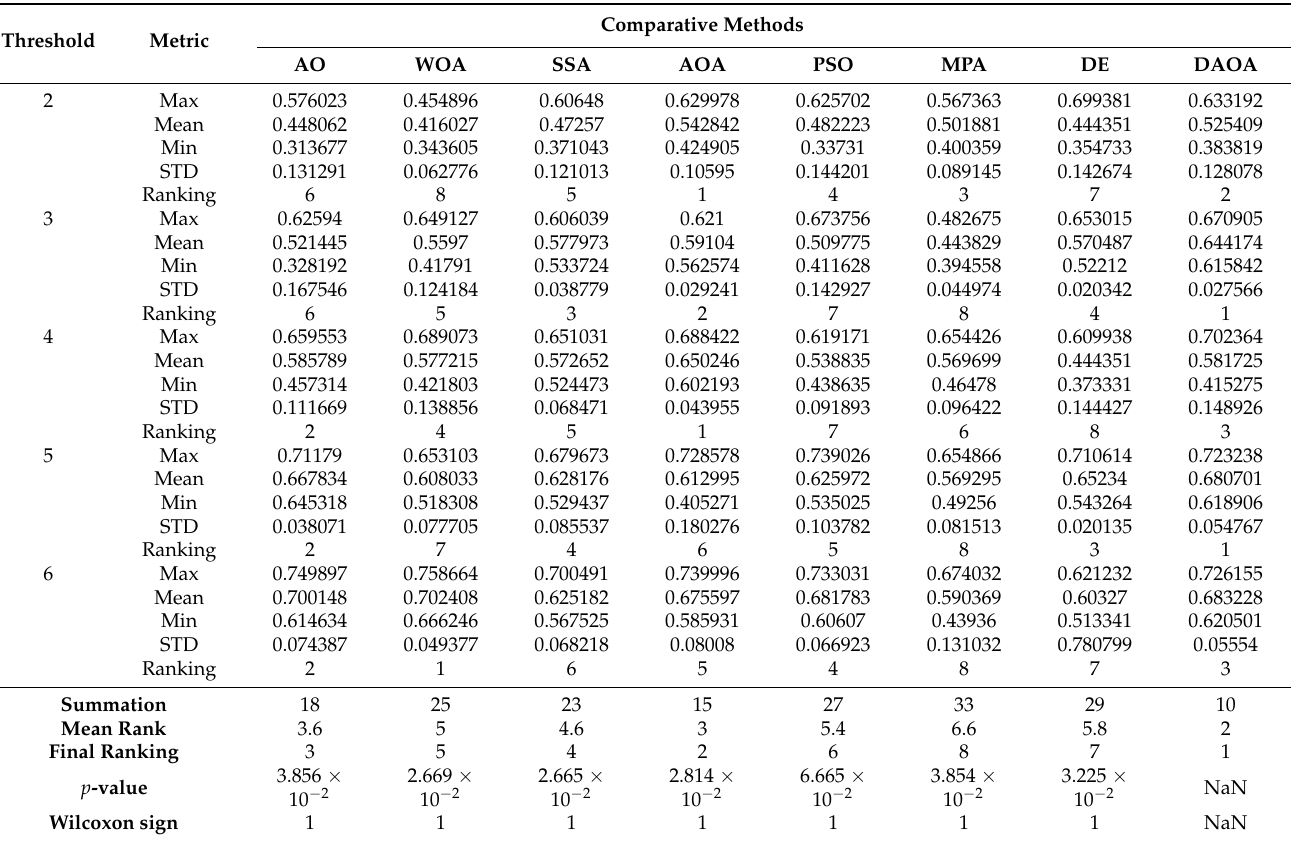
Table 17. The SSIM results of the test case